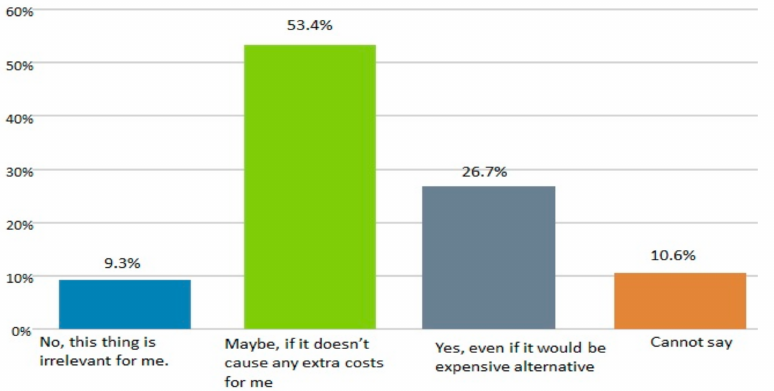
Figure A4. The willingness to change energy provider to a 100% renewable energy